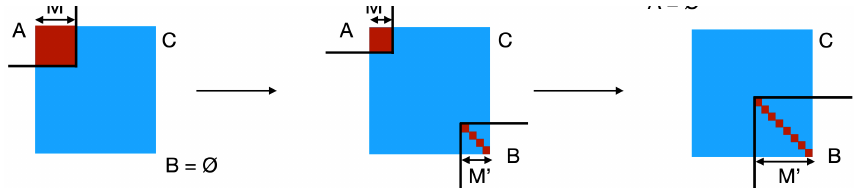
Figure 6 . Small black hole (region A ), radiations (region B ) and the confined sector (region C ) in terms of matrix degrees of freedom. (There is an ambiguity regarding whether the off-diagonal elements (strings between D-branes) should be included in region B .)